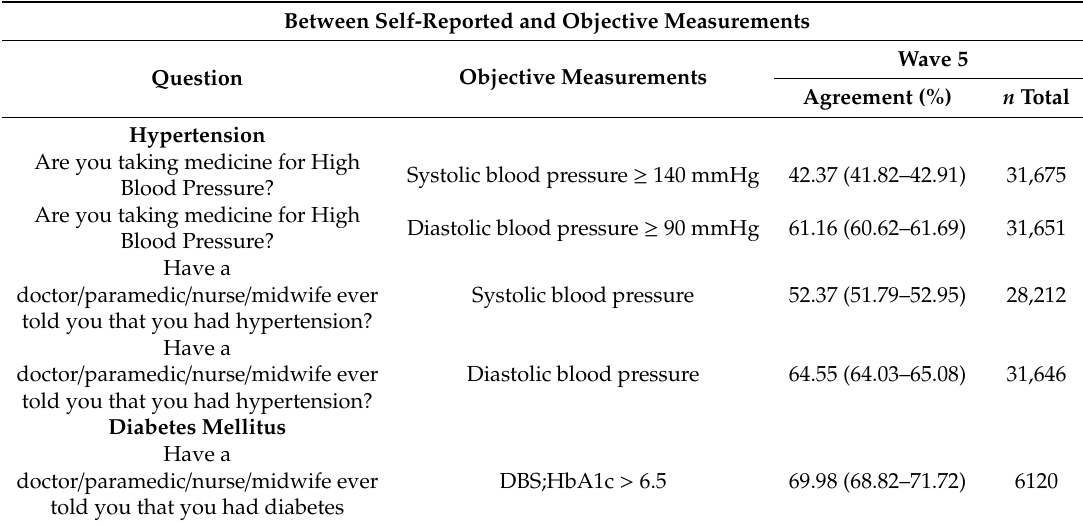
Table 5. Agreement of Self-reported question and objective measurement in IFLS Adult Population.